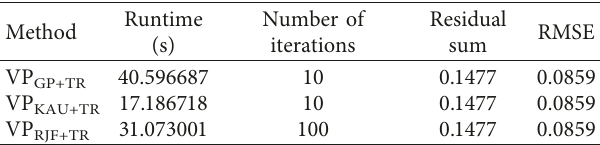
Figure 2: Change in parameters with respect to the number of iterations. (a) VP Table 1: Parameter results. Table 2: Quantitative comparison of performance for each